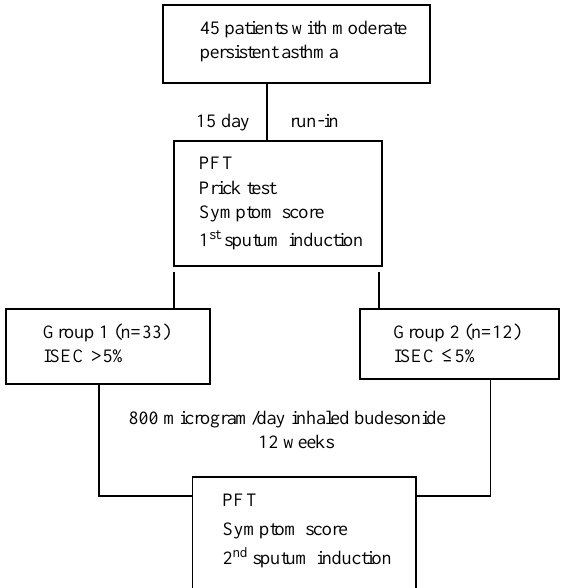
FIG. 1. Study design. PFT, pulmonary function test; ISEC, induced sputum eosinophil